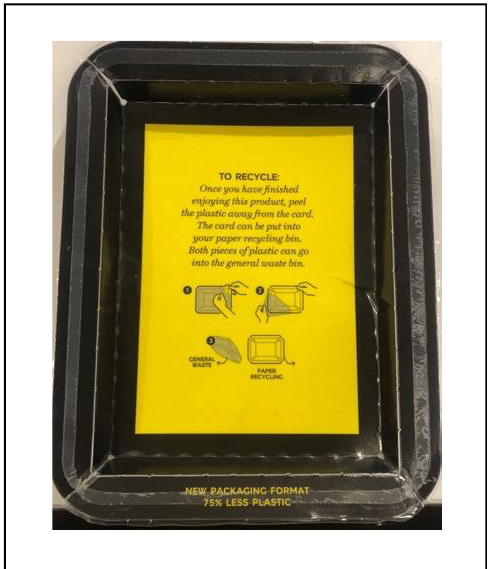
Figure 1. Example of food package with recycling information. This question was asked to determine whether consumers were likely to follow recycling instructions if added to food packaging using a five-point category scale (1: would definitely not follow the instructions to 5: would definitely follow the instructions). Table 1. Summary of food packaging materials included in the ranking task and preference